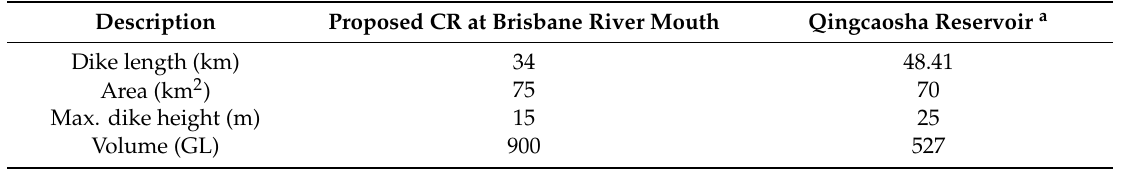
Table 4. Comparison of proposed CR parameters with Qingcaosha